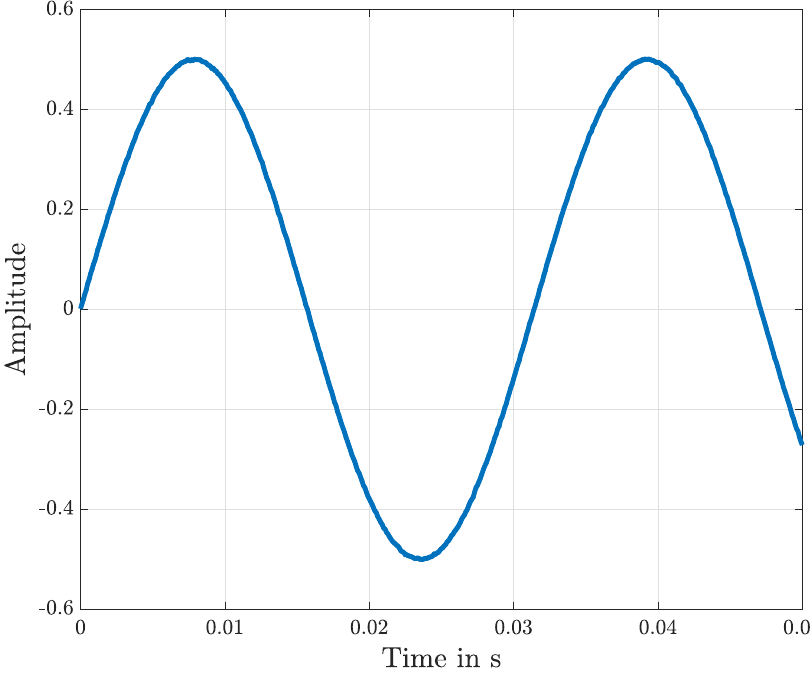
Figure 5. Graphical representation of the position y ( t ) with